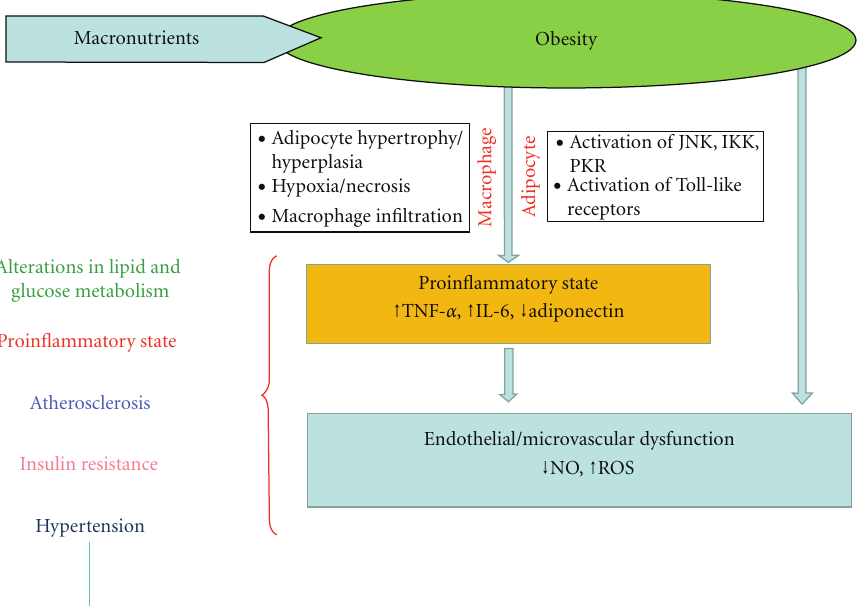
Figure 1: Mechanisms linking abdominal obesity and metabolic syndrome. TNF- α : tumour necrosis factor alpha; IL-6: interleukin 6; NO : nitric oxide; ROS: reactive oxygen species; JNK: c-jun N-terminal kinase; IKK: Inhibitor of k kinase; PKR: protein kinase